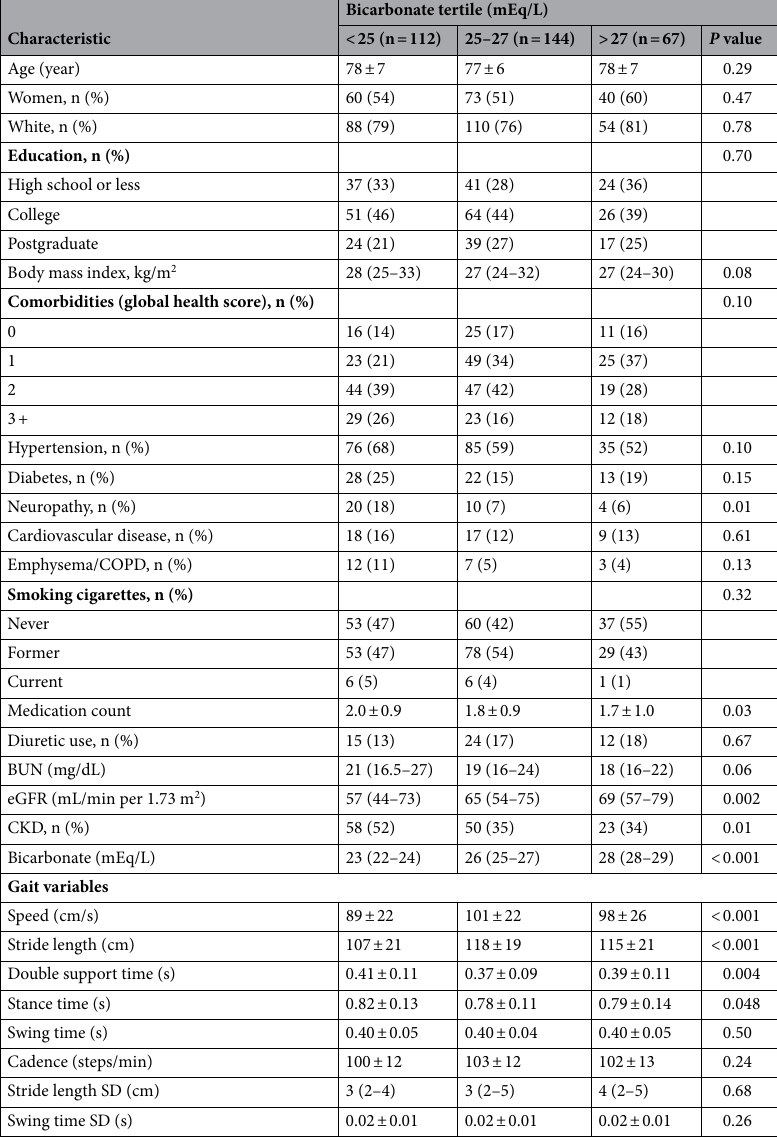
Table 1. Participant characteristics by serum bicarbonate tertile. Data are expressed as mean ± SD, median (interquartile range), or count (percentage). Baseline comparisons among bicarbonate tertiles were conducted using one-way analysis of variance (ANOVA) or Kruskal–Wallis test as appropriate for continuous variables and Pearson’s chi-squared test for categorical variables. Homoscedasticity was assessed using Bartlett’s test. CKD was defined as eGFR < 60 mL/min per 1.73 m 2 . N = 323 total. BUN blood urea nitrogen, CKD chronic kidney disease, COPD chronic obstructive pulmonary disease, eGFR estimated glomerular filtration rate, SD standard